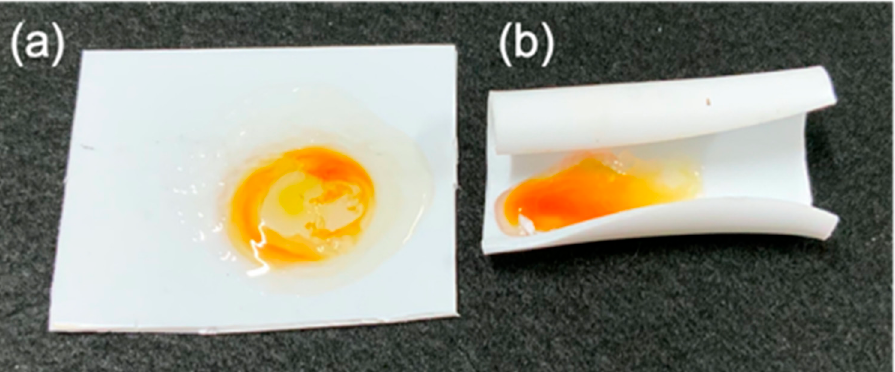
Figure 7. Photographs illustrating the curing of the (BADGE + PA + EM) adhesive on a polystyrene plate by ( a ) microwave heating (500 W, 20 min) and ( b ) by heating in an electric furnace (20 min).